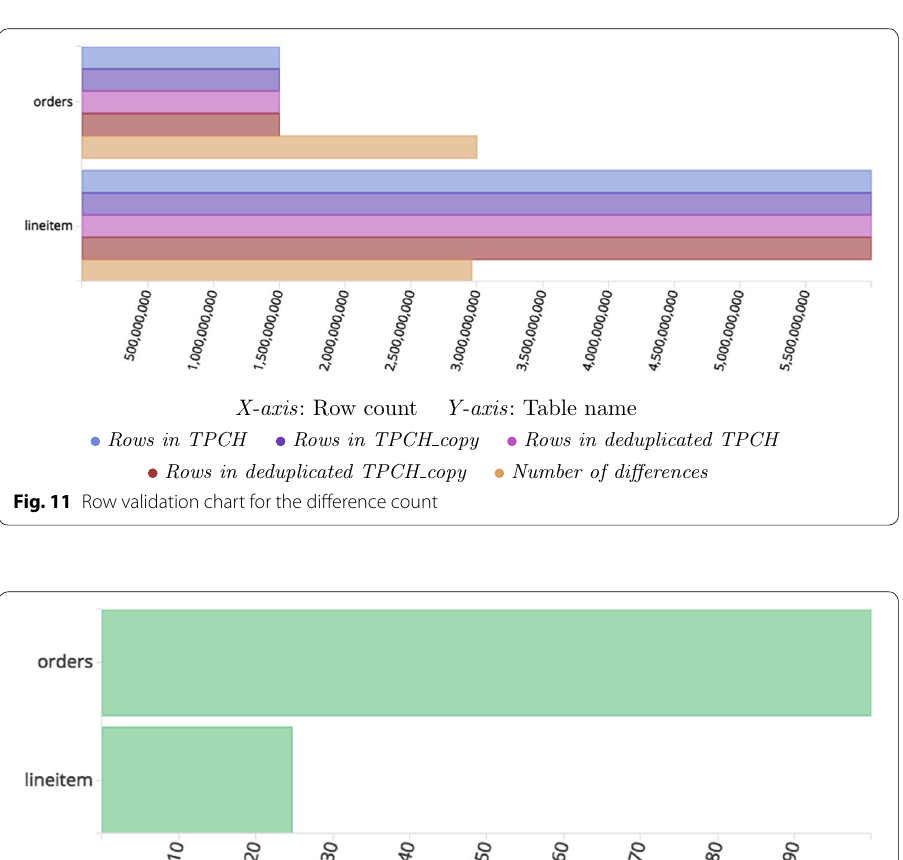
Fig. 12 Row validation chart for the difference percentage. X-axis: Difference percentage; Y-axis: Table name